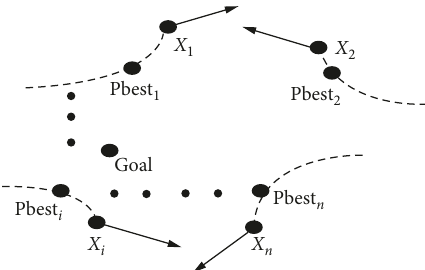
Figure 1: Sketch map of the particle swarm optimization